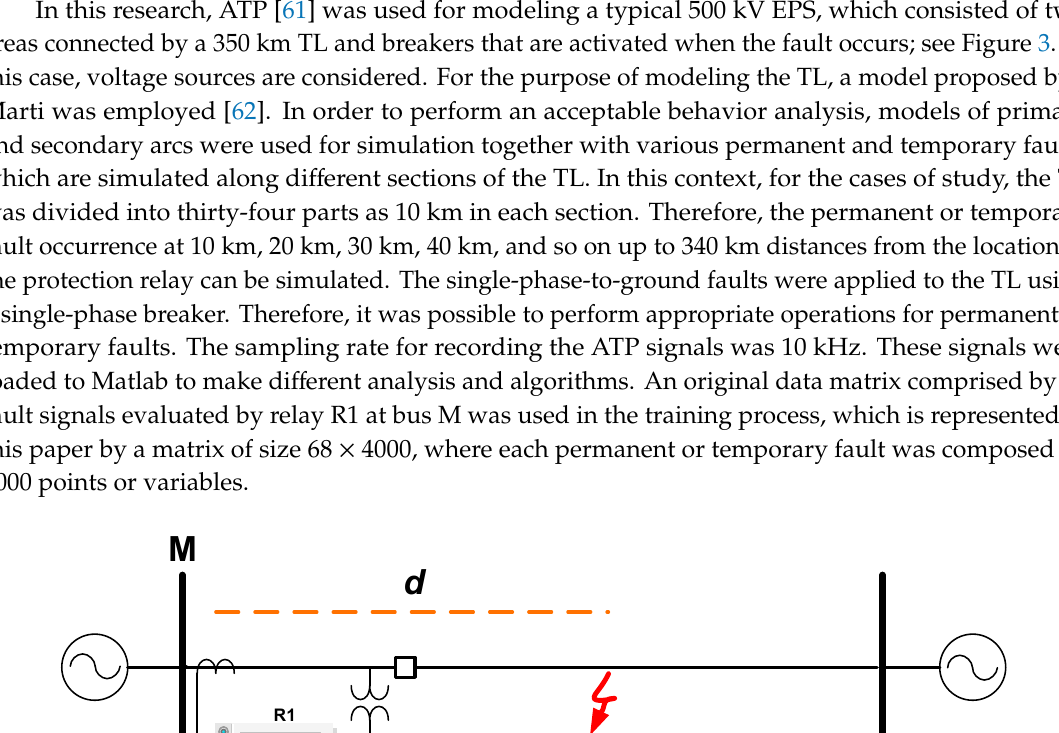
Figure 4. Voltage signal due to the temporary fault. During this last stage, from point B to point C, it was noticeable in the line a small and normal system frequency voltage sinusoidal component, which was caused by the electrostatic coupling between the two healthy phases and the faulted phase.